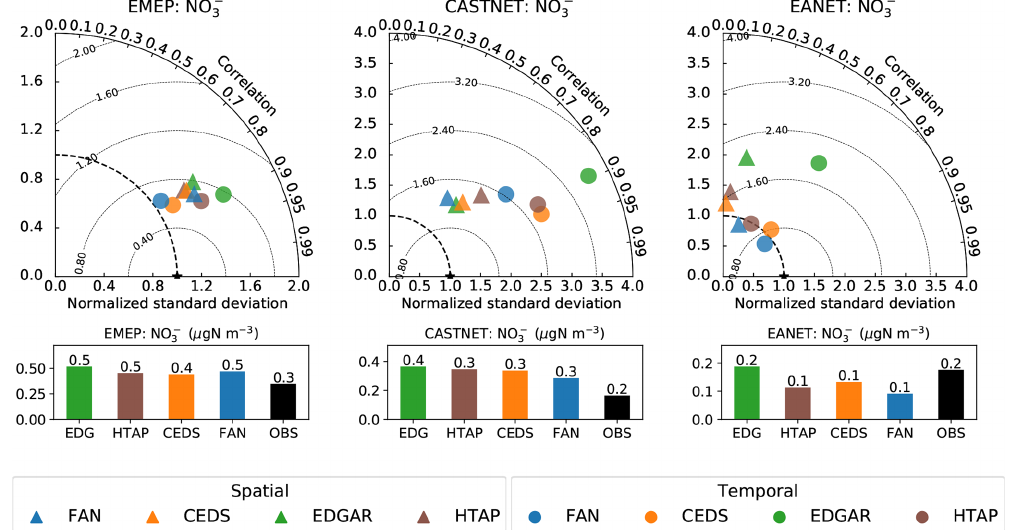
− concentration in the EMEP, CASTNET and EANET networks. Average concentrations for 3